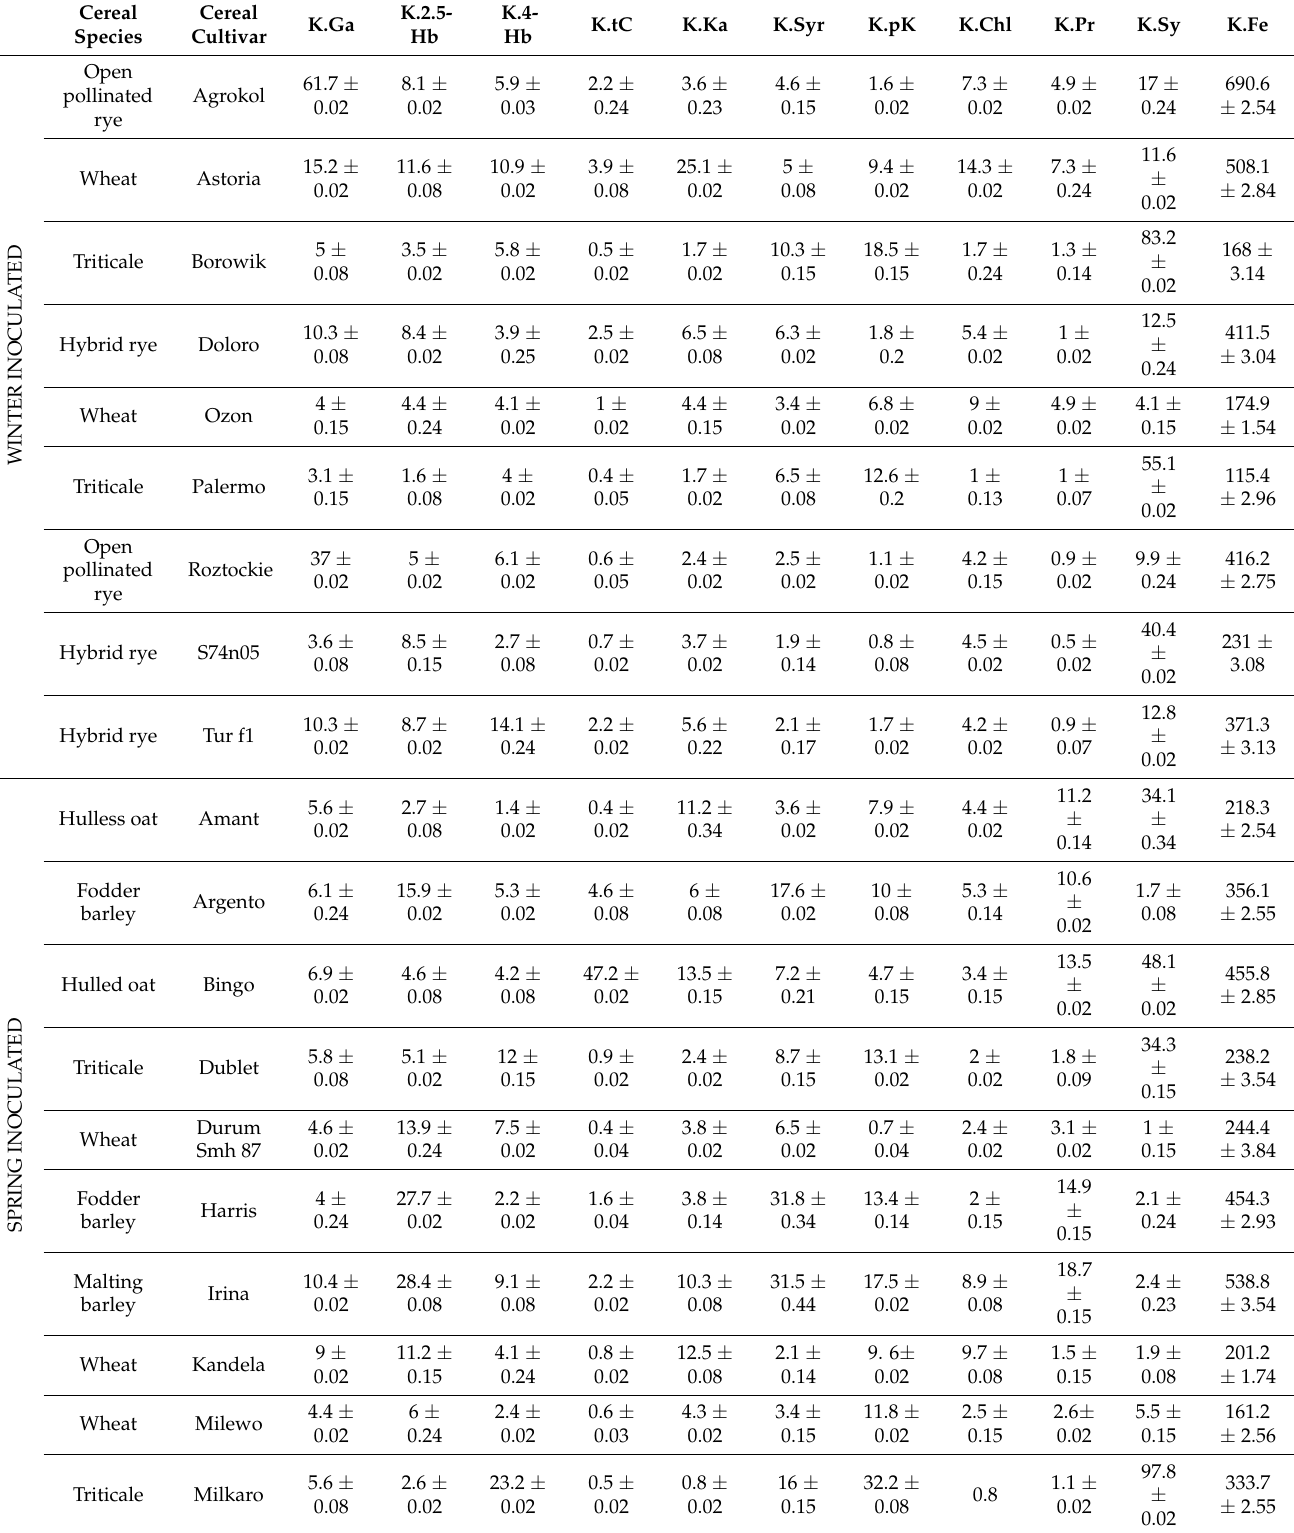
Table 6. Concentration of individual phenolic acids in extracts obtained from inoculated cereal